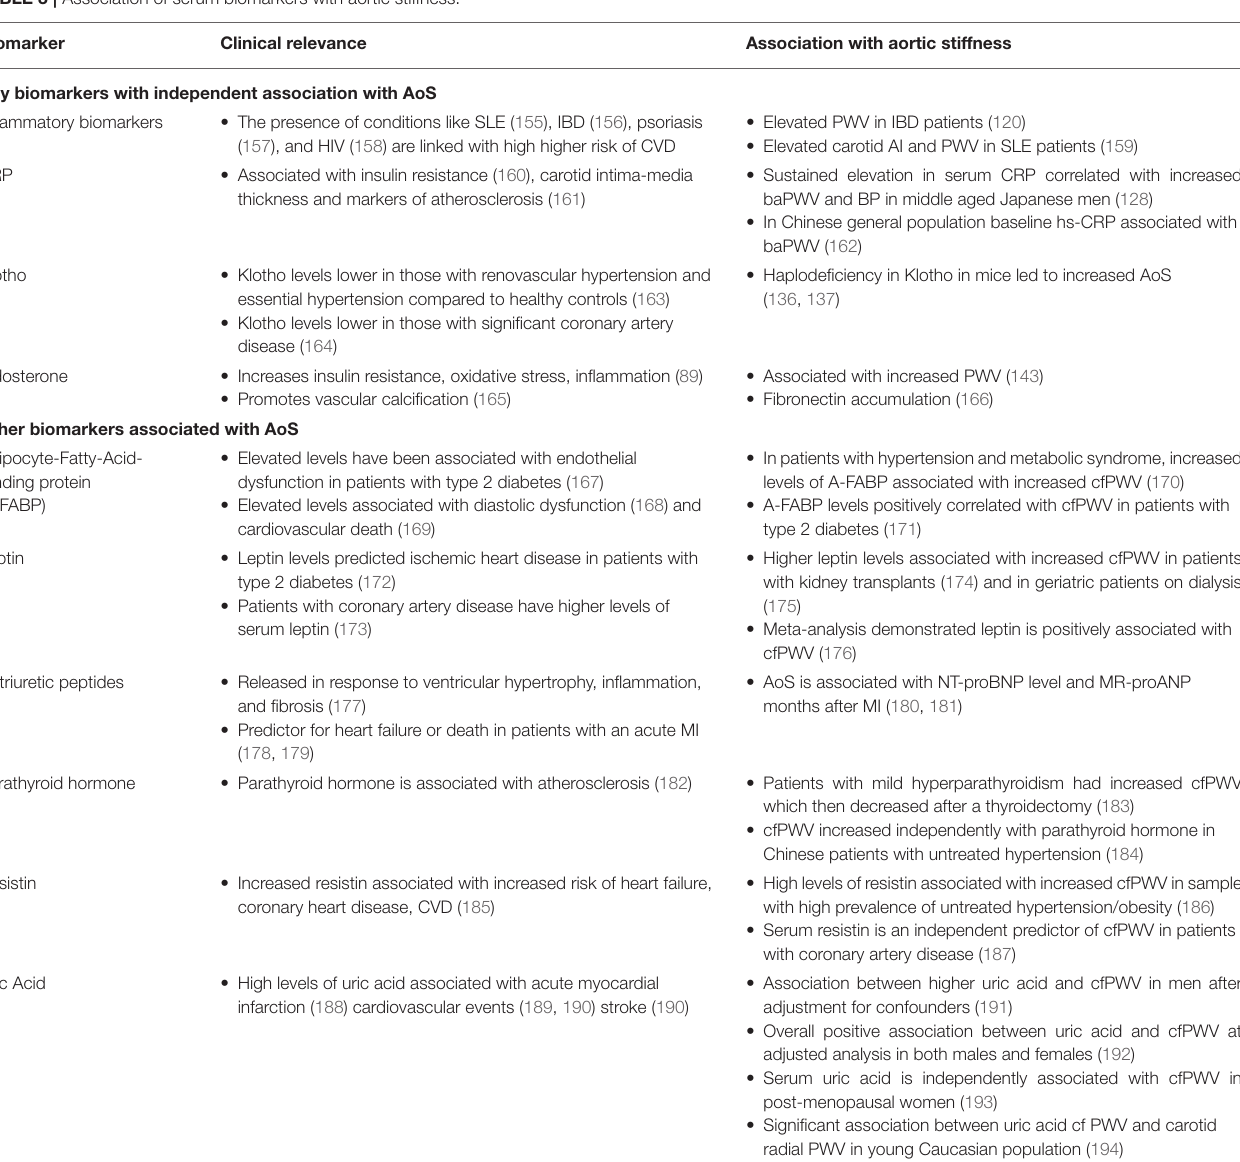
TABLE 3 | Association of serum biomarkers with aortic